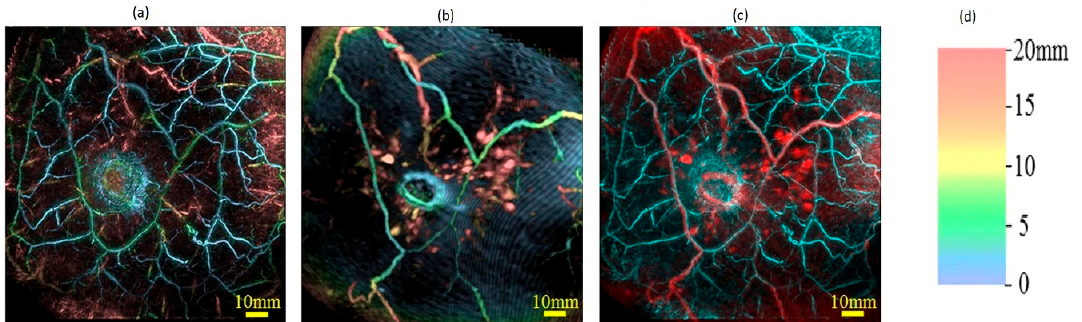
Figure 4. Comparison of PA and MR images of a healthy breast ( a ) PA image, ( b ) MR image, and ( c ) Fused PA-MR image with PA (cyan) and MR (red). Signals are colored according to the depth using the color chart shown in ( d ). Reproduced from Toi et al. [39], which is licensed under a Creative